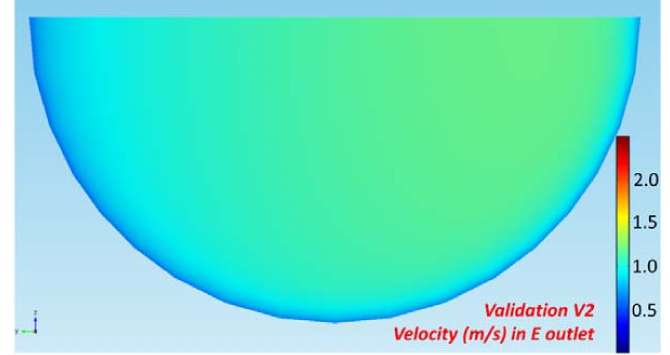
Figure 7. Example of a velocity contour